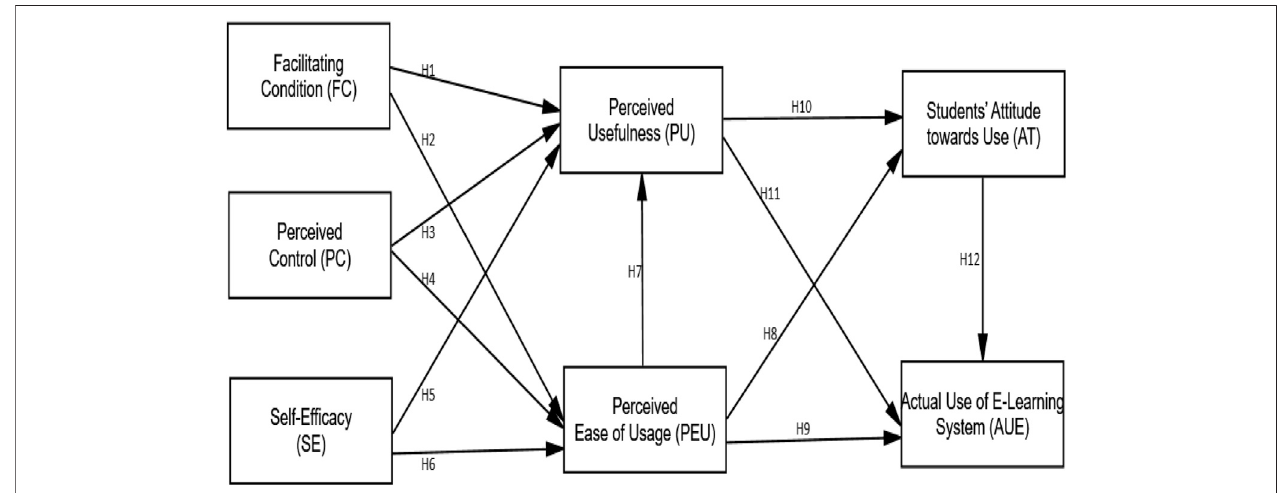
FIGURE 1 | Research model and